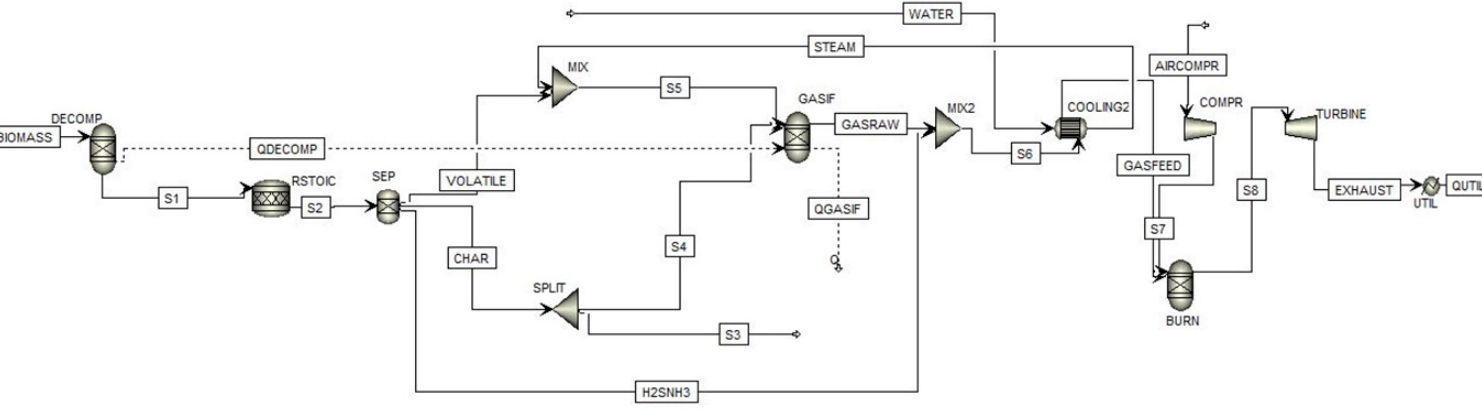
Figure 3. Flowchart of the plant evaluated in this study (the hatched streams are the heat streams, representing thermal recoveries; the continuous streams are the material streams), considering steam as the gasifying agent